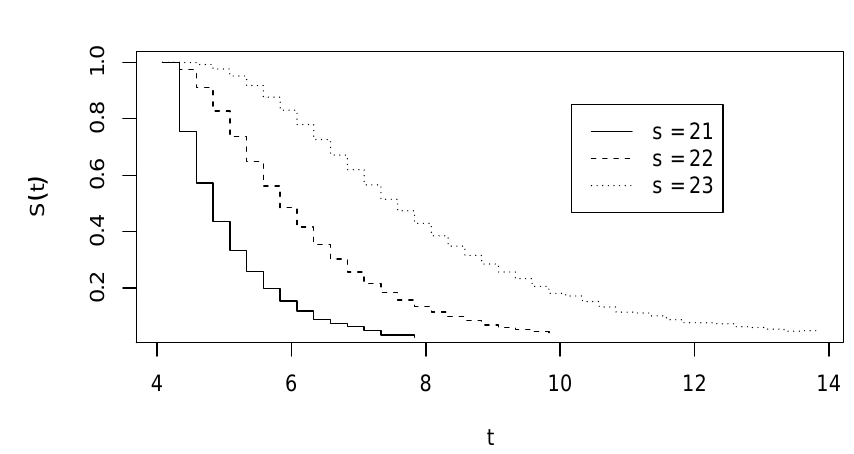
Figure 5 – One Sample Survival functions for different values of s for real data set.